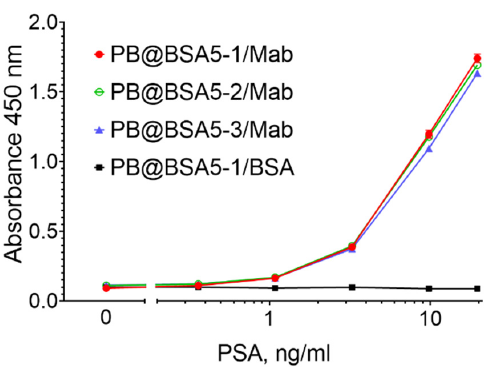
Figure 6. PSA calibration curve assay obtained for three batches of PB@BSA5 nanoparticles conju- gated with anti-PSA MAbs or BSA. n = 3, mean ± SD. Error bars are very small and hidden by the data points.